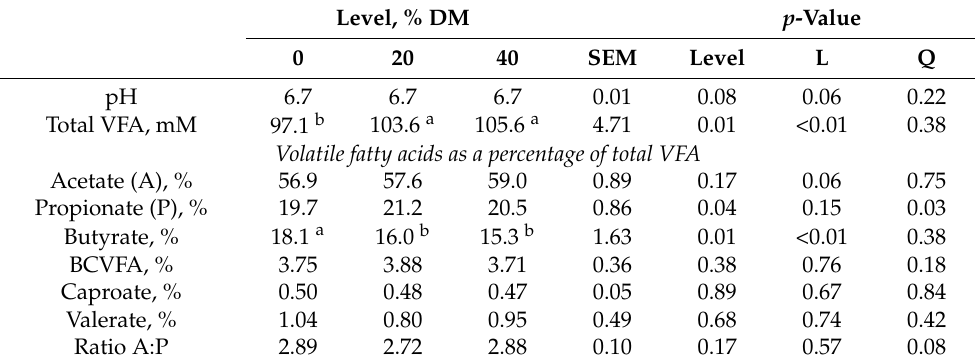
Table 6. Total volatile fatty acids (VFA) concentration and percentages of individual VFA of total VFA in samples of sorghum ensiled with 0, 20, or 40% DM unsalable vegetable mixture, with or without a probiotic inoculant after 24 h in vitro batch culture